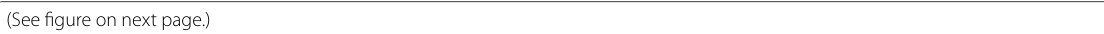
figure on next Fig. 1 EMS induced angiogenesis in endometrial tissue. A The microvessel density in normal endometrium, eutopic endometrium and ectopic endometrium. The microvasculature was stained for CD34 by immunohistochemistry, while all the tissues were also stained by H&E and iron. The number in each group was 8. B Tube formation of hUVECs induced by hESCs and hEECs in a coculture system with chambers. C Histogram representing the microvessel density in normal endometrium, eutopic endometrium and ectopic endometrium. The number in each group was 8. D Histogram representing the tube number in each group. The number in each group was 3. * represents p <